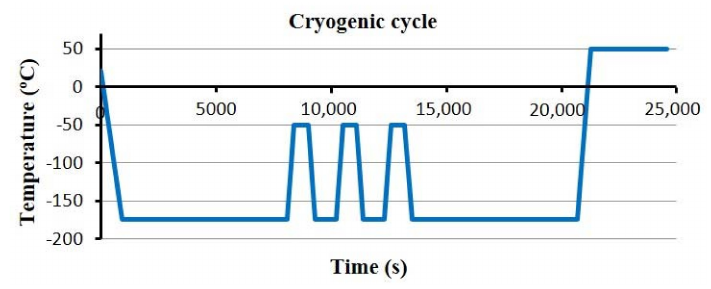
Figure 6. The applied multistage cryogenic